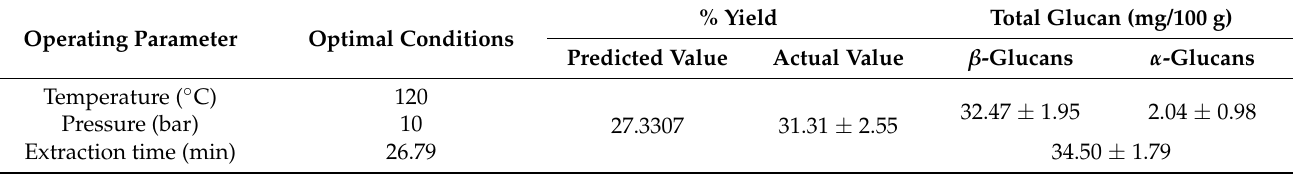
Table 2. Optimal conditions for SCGs extraction with pressurized hot water and the predicted and the actual values of the